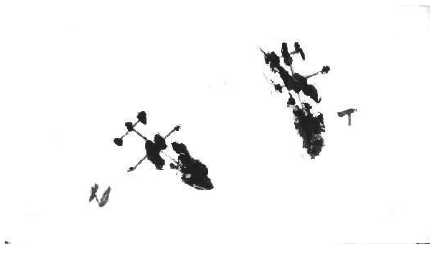
Figure 2: The footprint for sciatic nerve function index of